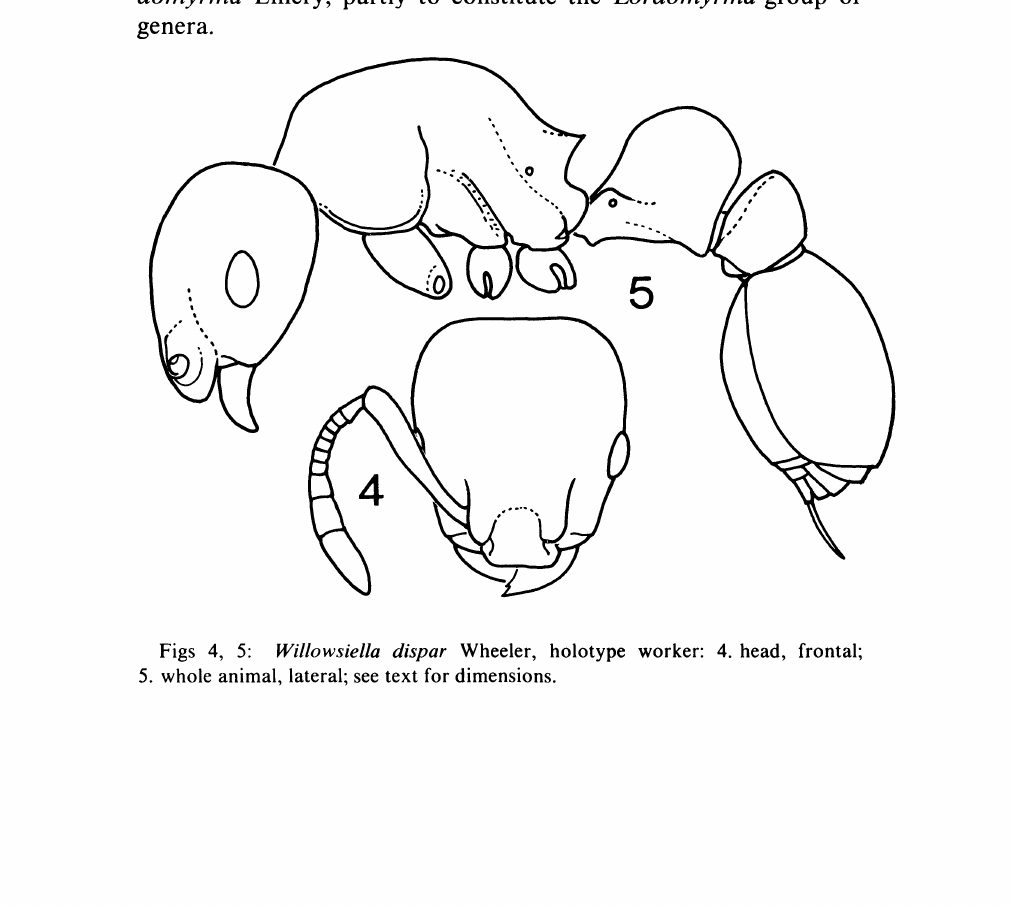
Willowsiella dispar Wheeler, holotype worker: 4. head, frontal; 5. whole animal, lateral; see text for